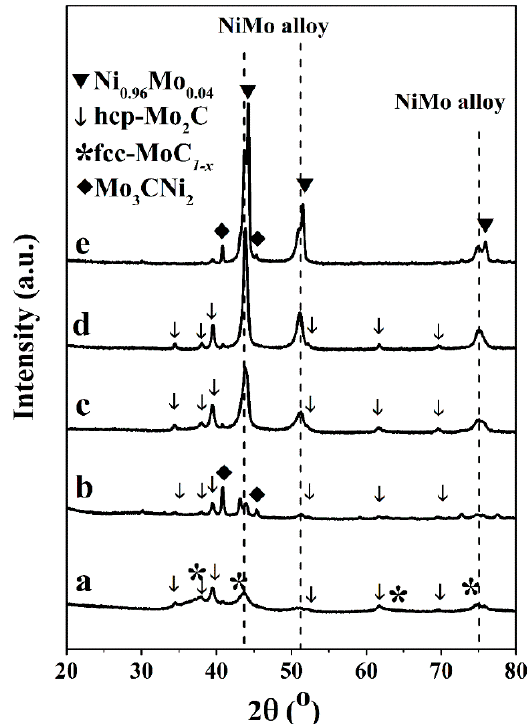
Figure 6. XRD patterns of the calcined and reduced catalysts: ( a ) Ni 0.5 MoC–SiO 2 (400/600); ( b ) Ni 1 MoC–SiO 2 (400/600); ( c ) Ni 2 MoC–SiO 2 (400/600); ( d ) Ni 4 MoC–SiO 2 (400/600); ( e ) Ni 6 MoC–SiO 2 (400/600).